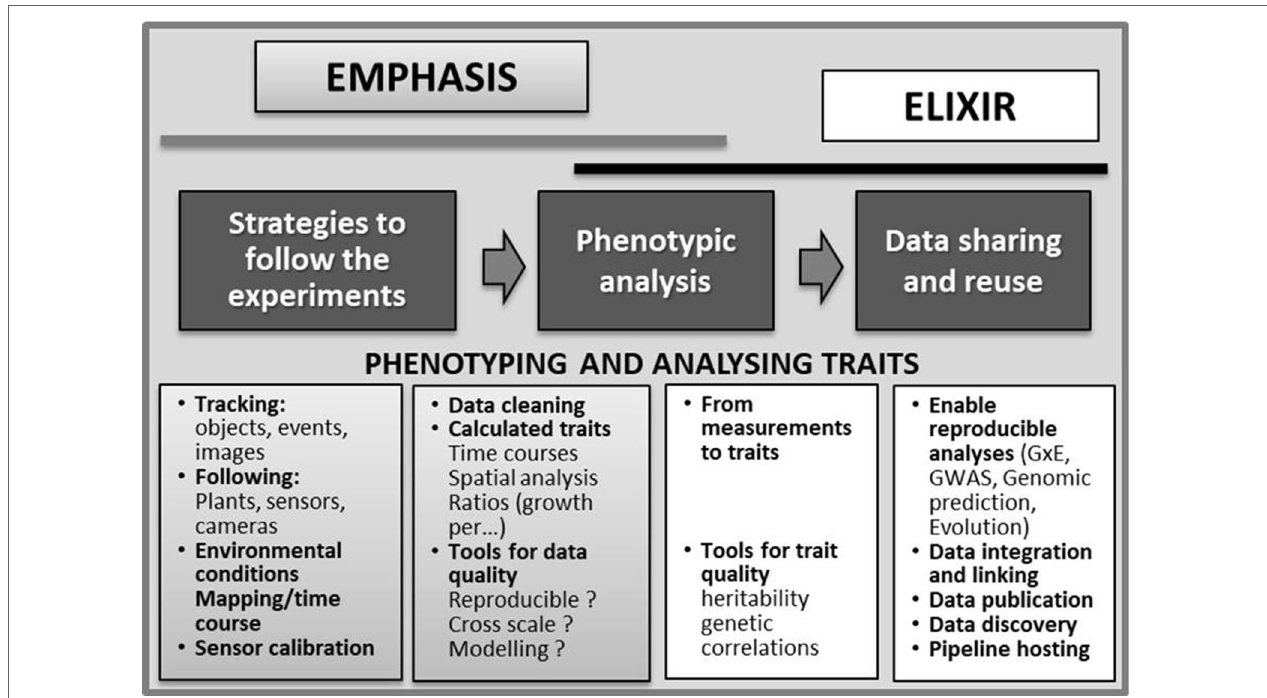
FIGURE 2 | Data flow from trials to genetic analyses and dissemination considered within the EMPHASIS and ELIXIR which are two ESFRI infrastructures, dedicated to phenomics and data sharing and integration, respectively. ESFRI is the European Strategy Forum on Research Infrastructures, aiming at developing scientific integration of Europe and to strengthen its international outreach. The relation between data production/analysis and modeling will be promoted by the interaction of the academic/industrial communities focused on phenomics (e.g., EMPHASIS) as well on crop modeling (e.g., AgMIP project—Agricultural Model Intercomparison and Improvement Project, http://www.agmip.org/) (adapted from EMPHASIS,